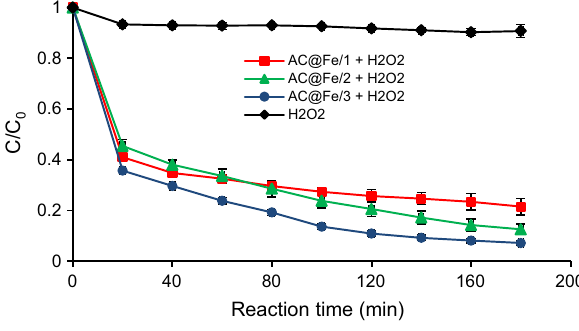
Fig. 7 Kinetics of Rhodamine B removal by heterogeneous Fenton using AC@Fe/1, AC@Fe/2 and AC@Fe/3 catalysts (catalyst dose 0.2 g/L; H 2 O 2 4 mmol/L; pH 4.2; T = 28 °C; C 0 = 50